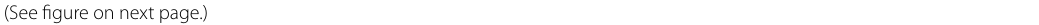
Fig. 3 Clinical data: A 46‑year‑old woman with right breast cancer (T3N1). Histologic findings demonstrated grade II invasive ductal carcinoma (luminal B1). Post‑operative pathologic findings revealed IDC grade I with low grade DCIS with partial effect to therapy confirmed with BCS(ypT1N1). A The first row is (a–c) Breast MR images prior to neoadjuvant chemotherapy demonstrate a 4.6 3.9 cm irregular microlobulated enhancing mass × in the left breast on axial post‑contrast (a) images restricted diffusion (b) with an ADC value of 0.9 (c). The second row (d–f) Breast MR images